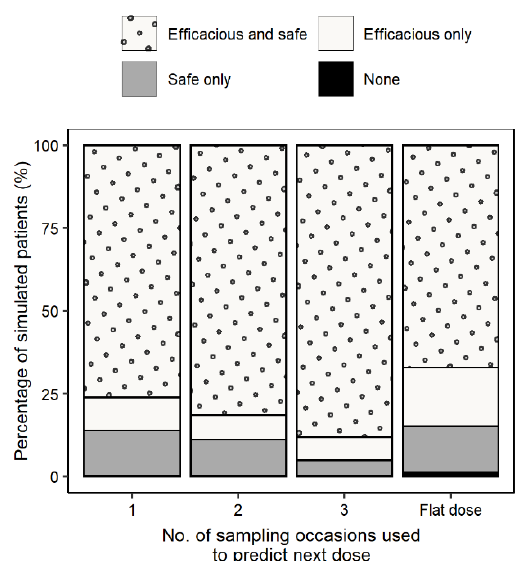
Figure 4. Percentage of patients reaching both efficacy and safety, only efficacy, only safety, and neither efficacy nor safety using information from one, two, and three sampling occasions to derive individual PK parameters. The true individual PK parameters were obtained from a rich sampling in order to derive the true optimal dose for comparison.